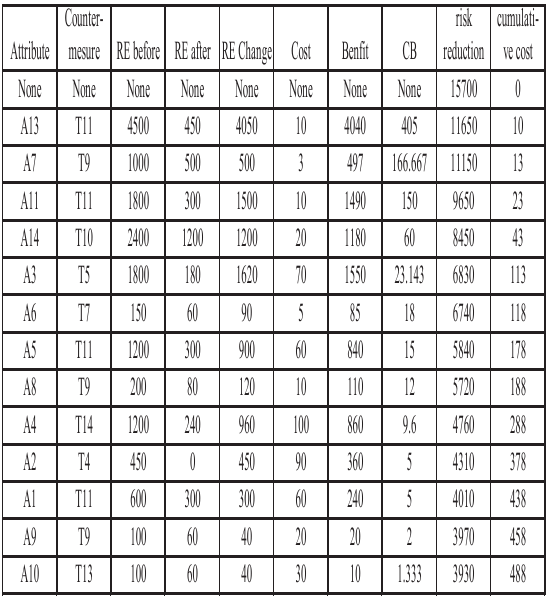
Table 4: The Optimal Strategy Computed For The